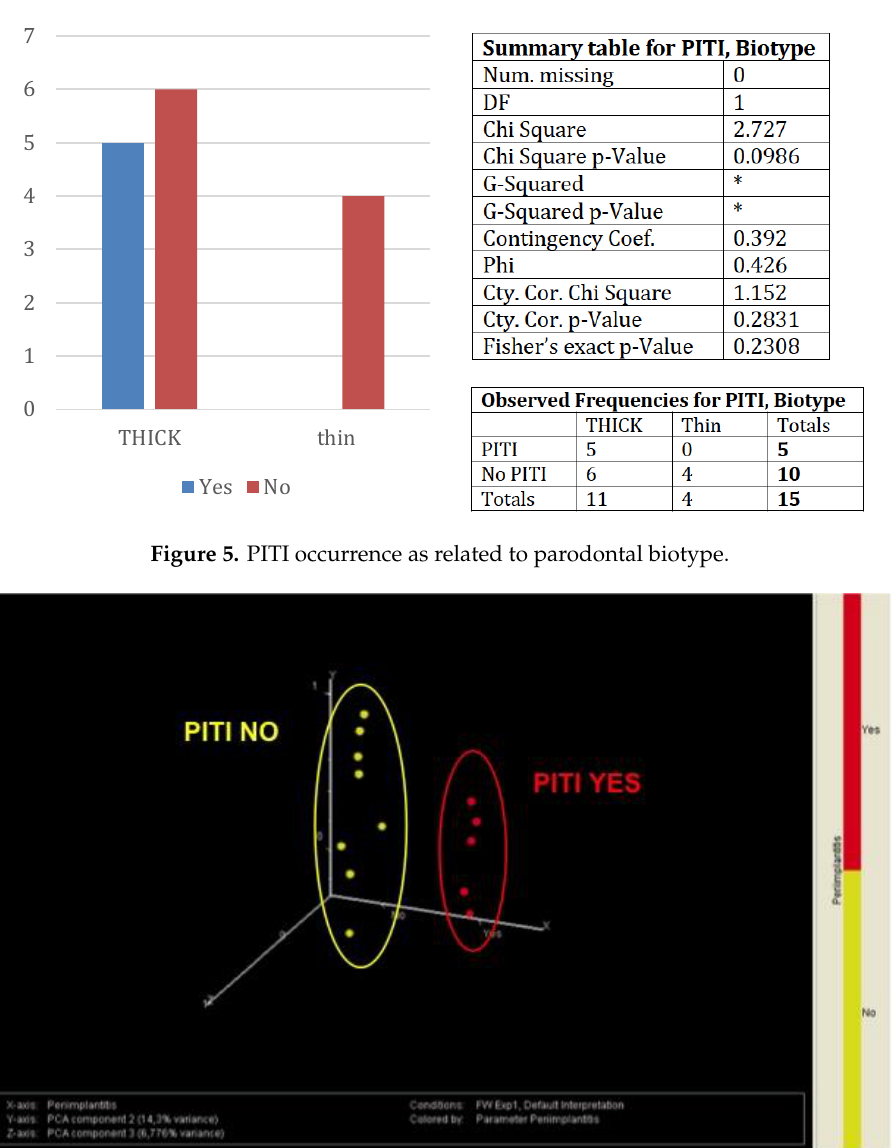
Figure 6. Principal component analysis of variance showing differences in miRNA expression in implants with or without PITI.